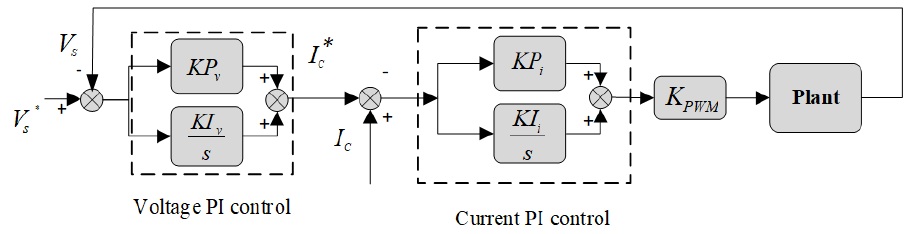
Figure 9. Block diagram of the grid-islanded inverter control loop.